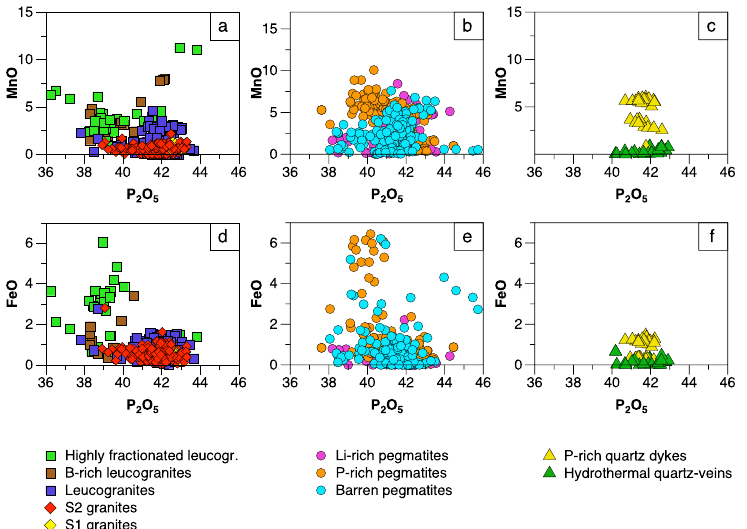
Figure 4. Binary plots of P 2 O 5 versus: ( a – c ) MnO; and ( d – f ) FeO, in apatite from the granitic, pegmatitic and hydrothermal veins, respectively. All the values in wt.%.